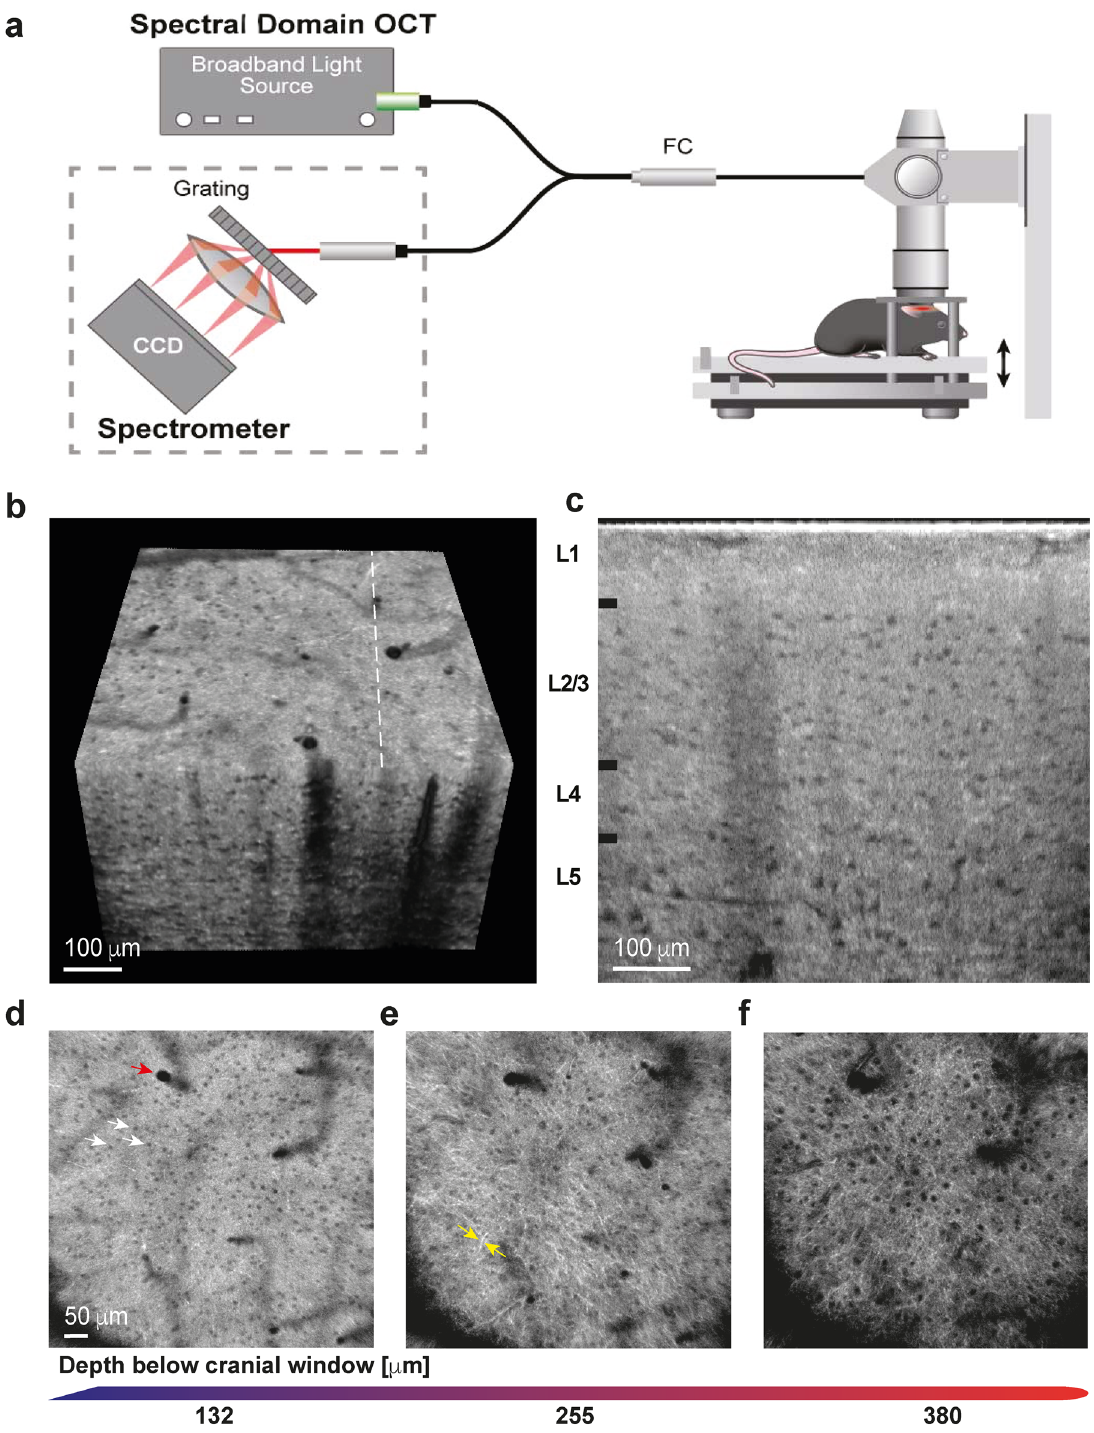
Figure 1. High-resolution cortical imaging by highly stable OCT system in vivo. ( a ) Schematic of our OCT imaging setup showing fixation of a mouse head by a customized head-clamp that is mounted on a translational (z-direction) stage. ( b ) A sampled 3D OCT volume (0.7 X 0.7 X 0.4 mm) of the mouse visual cortex ( c ) Sampled OCT b-scan, at the location marked by the dashed line in panel ( b ), of a cross-section of the five cortical layers (marked L1-L5) in the mouse visual cortex. Cell bodies appear as circular dark foci. ( d–f) Sampled high-resolution en face images at cortical depth ( d ) 132 µm, ( e ) 255 µm, and ( f ) 380 µm [contrast in ( d – f ) was manually enhanced to emphasize cell bodies]. Red arrow points to a blood vessel, the white arrow points to CNS cell bodies, and the yellow arrow points to a myelinated